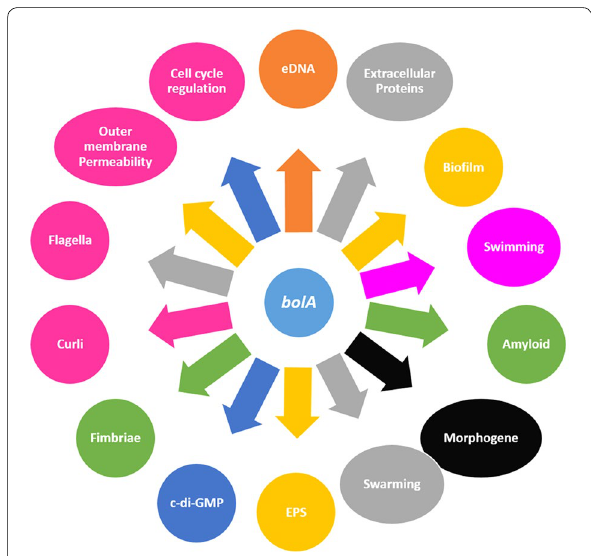
Fig. 1 Cellular mechanisms in E. coli connected to the bolA gene/ BolA